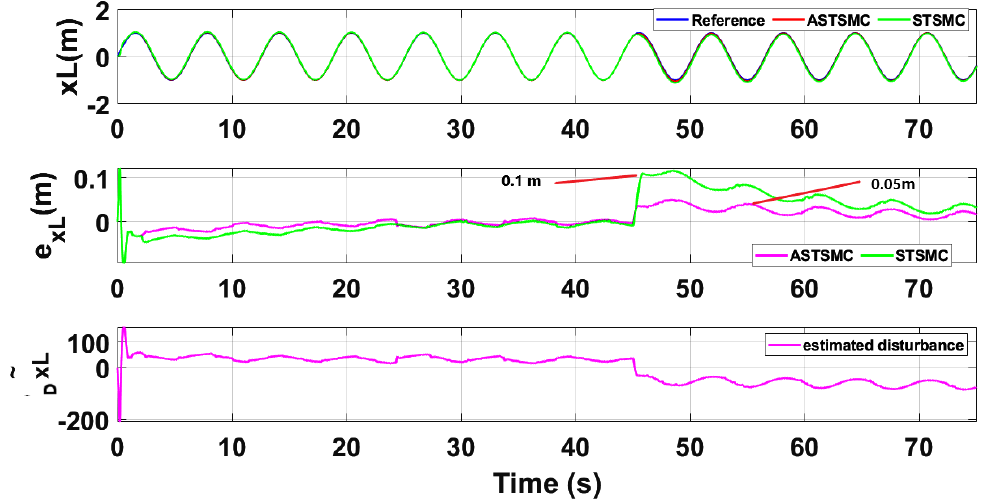
Figure 9. X leader tracking comparison under wind disturbance.